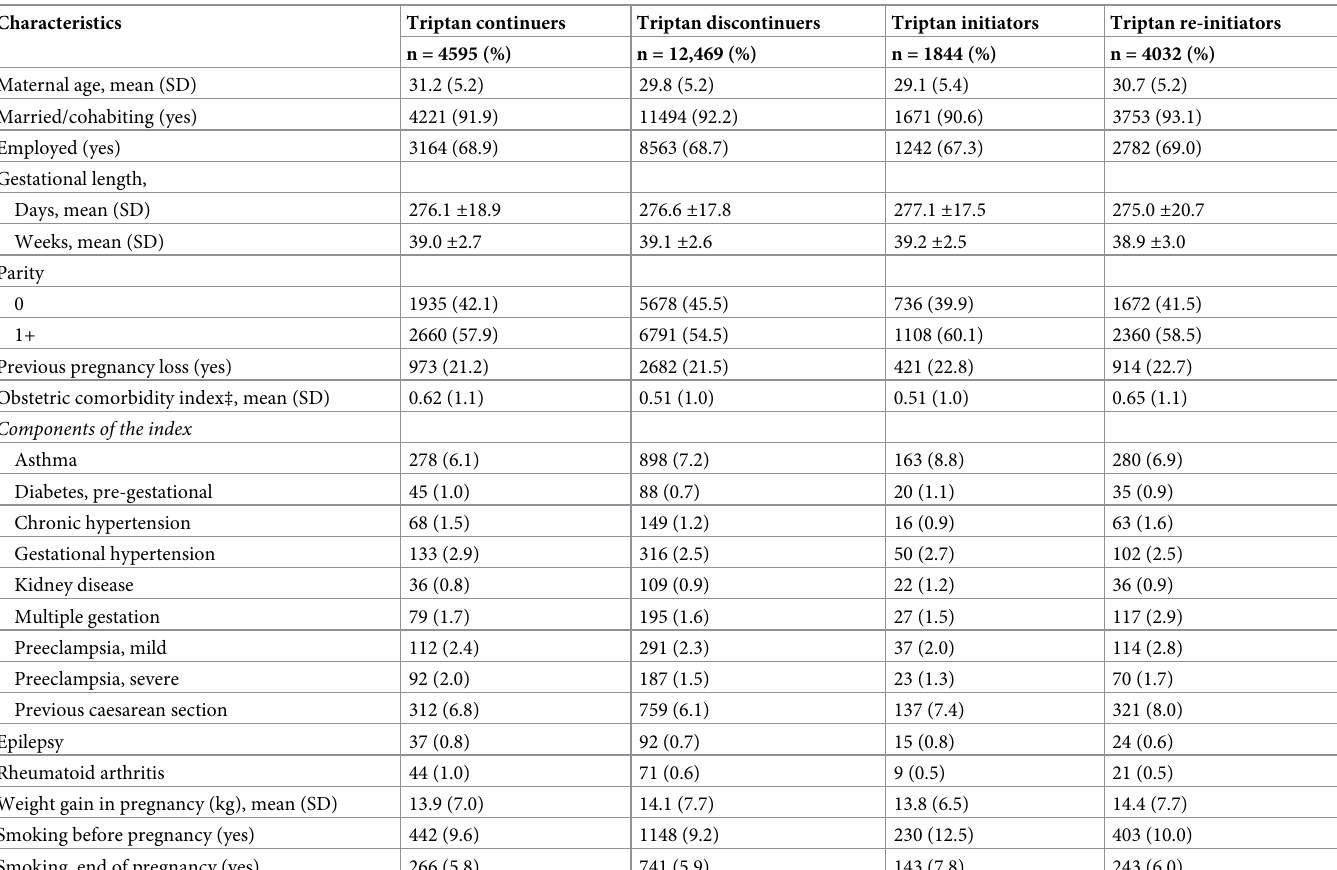
Table 2. Characteristics of the included women (n = 22,940), grouped by exposures, 2006–2017.